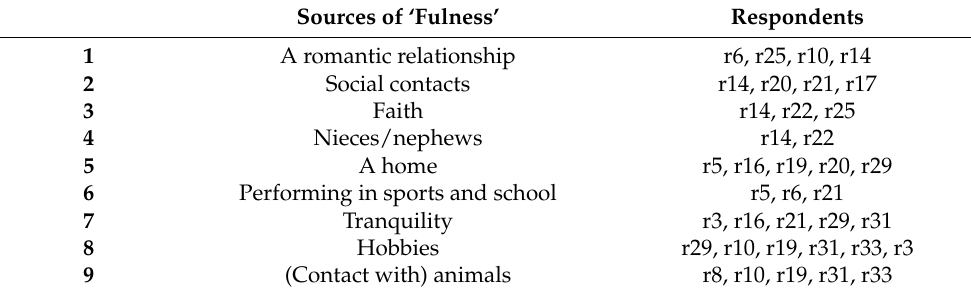
Table 4. Sources of ‘fulness’ that are or were present in the first life story.